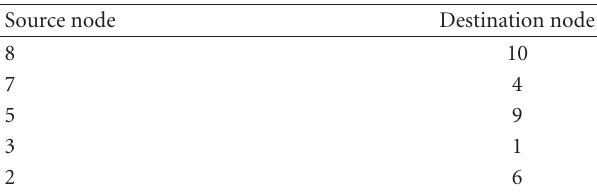
Table 6: Rate requirements of 5 sessions for random topology. Source